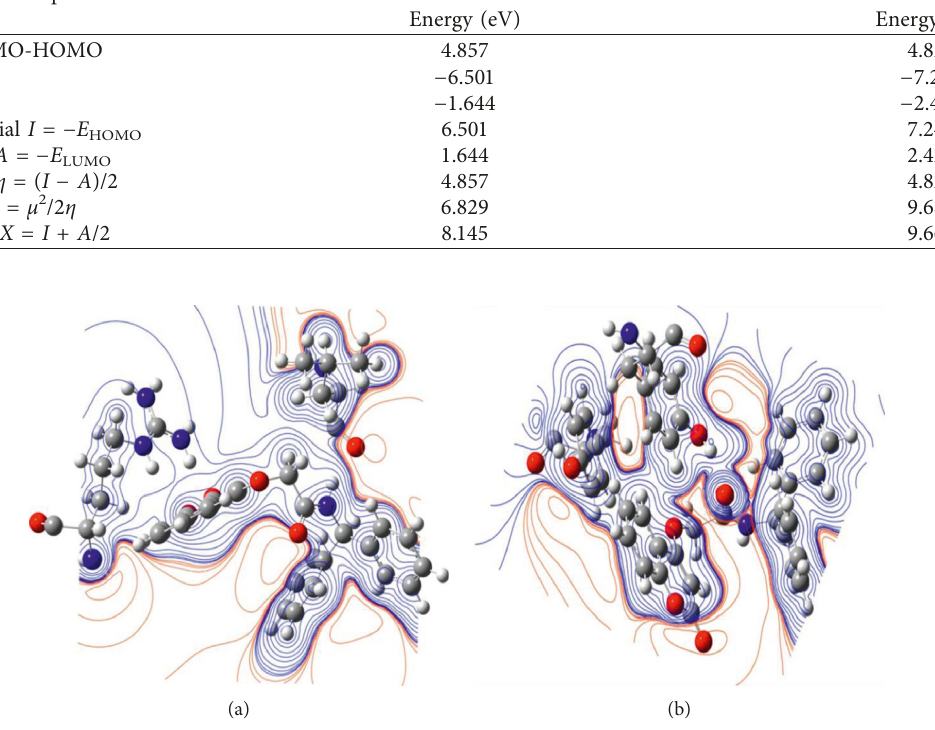
Figure 7: The electrostatic potential countermap of the (a) coumarin derivative and (b) cofactor molecules with active site amino acids of HSA.